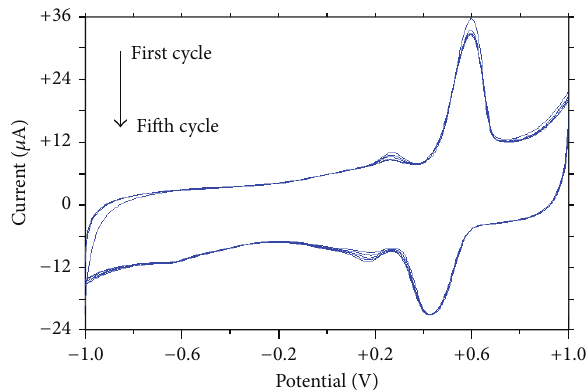
Figure 5: Multiple cycle voltammograms for 0.1 mM paracetamol in 0.1 M KH 2 PO 4 at a SWCNT/Ni-modified electrode. Scan rate: 100mVs −1 .